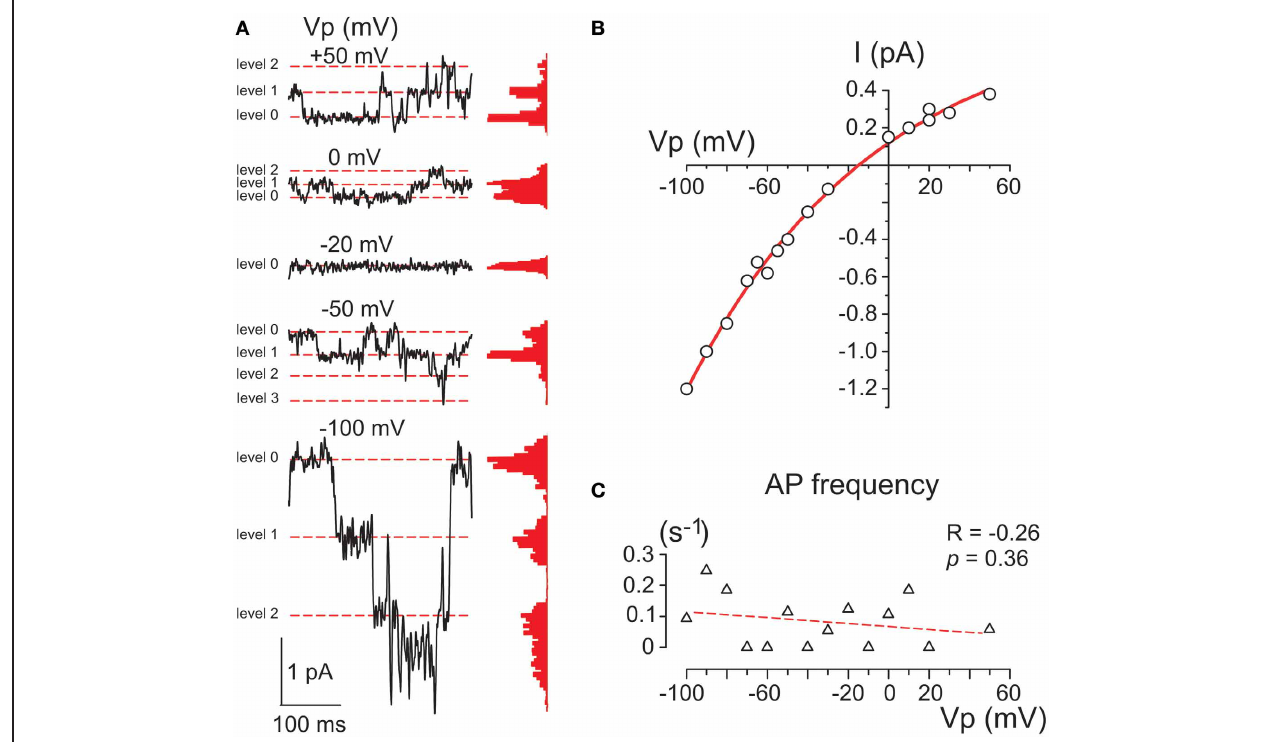
FIGURE 4 | Single GABA channels activated by photorelease of GABA. (A) Example traces of cell-attached currents through GABA channels activated on the decay of the response evoked by RuBi-GABA uncaging at different holding potentials of the recording pipette. Corresponding all current point histograms are shown on the right from each trace. Levels are indicated by red dashed lines. Data from a P2